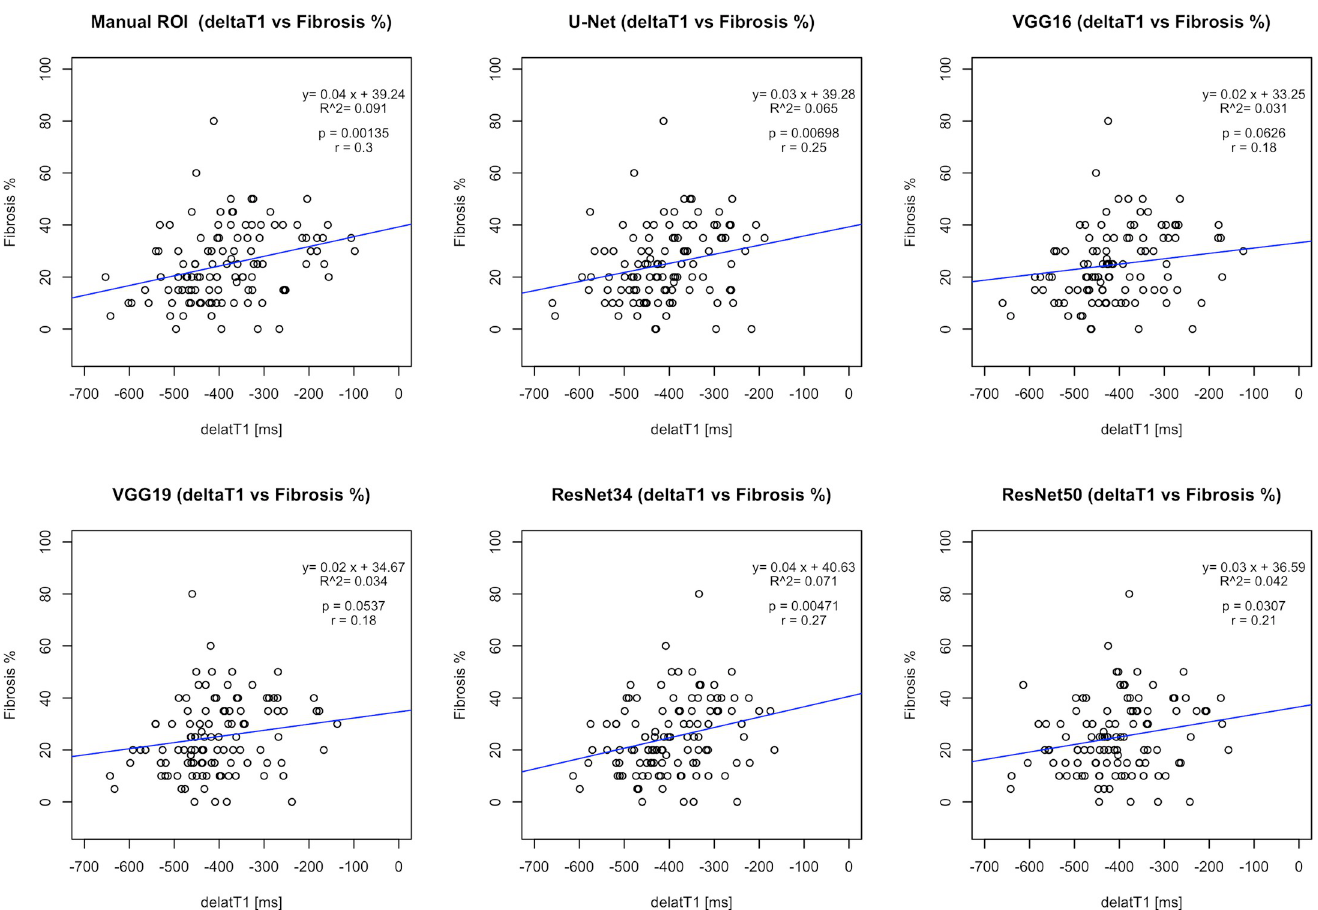
Fig 7. The correlation analysis and scatter plots of gold-standard manual ROIs [4], deep learning-based methods Δ T1 values with percentage fibrosis. The correlation results show postive correlation between MRI values and percentage fibrosis.